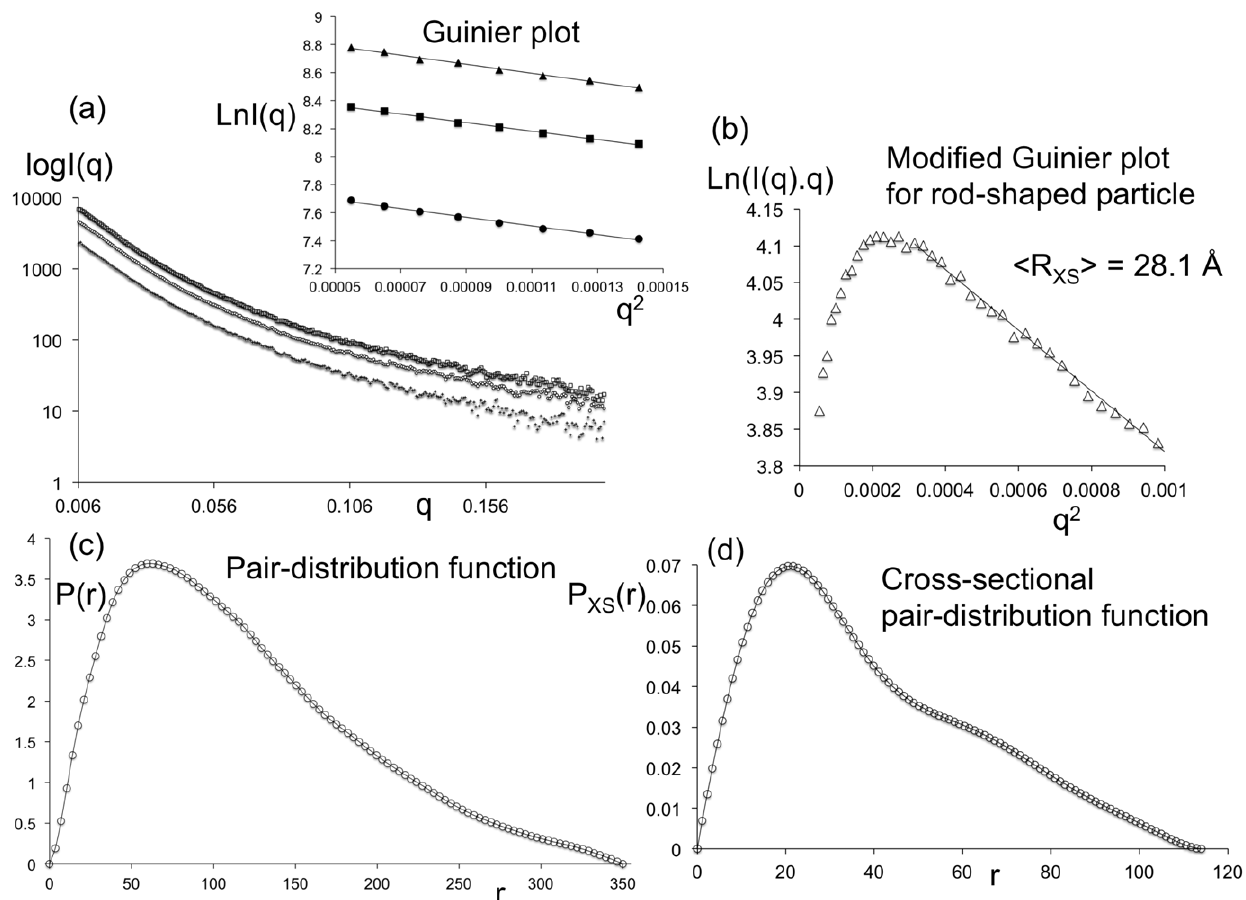
Figure 1. The size of tbParB-D120 assembly derived from the SAXS data. (a) Intensity (I) in arbitrary unit versus momentum transfer q in A˚ 2 1 are plotted at 3 different concentrations. The Guinier plot (lnI(q) versus q 2 , q in A˚ 2 1 ; lnI ( q ) ~ lnI (0) { R 2 graphs presented in this work are prepared using Excel H (Microsoft H corporation). A linear trend-line fitted to the data points is shown in each case. (b) The modified Guinier plot for rod-shaped particle (lnI(q)q versus q 2 , q in A˚ 2 1 , lnI ( q ) q ~ ln ( I ( q ) q ) q ? 0 { R 2 function P(r) versus pair-wise distance r in A˚. The pair functions shown here and in the figure 5 were calculated with the following boundary conditions: P(r=0)=0 and P(r $ D max )=0. (d) The cross-sectional pair-distribution function (P XS (r)) versus pair-wise distance r in